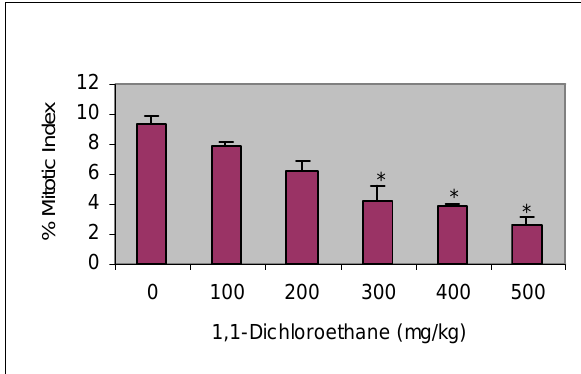
Figure 2: Effect of 1,1-Dichloroethane on the percent Mitotic Index.